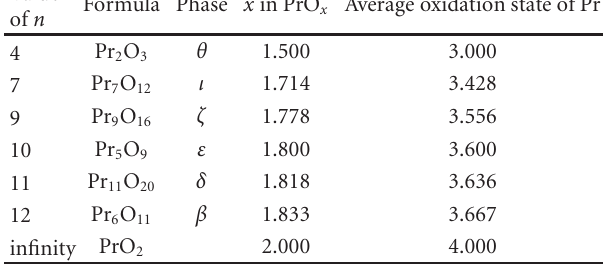
Table 1: Stoichiometry of the known members of the homologous series Pr n O 2 n − 2 . Reproduced from J. Solid State Electrochem. , 2001,